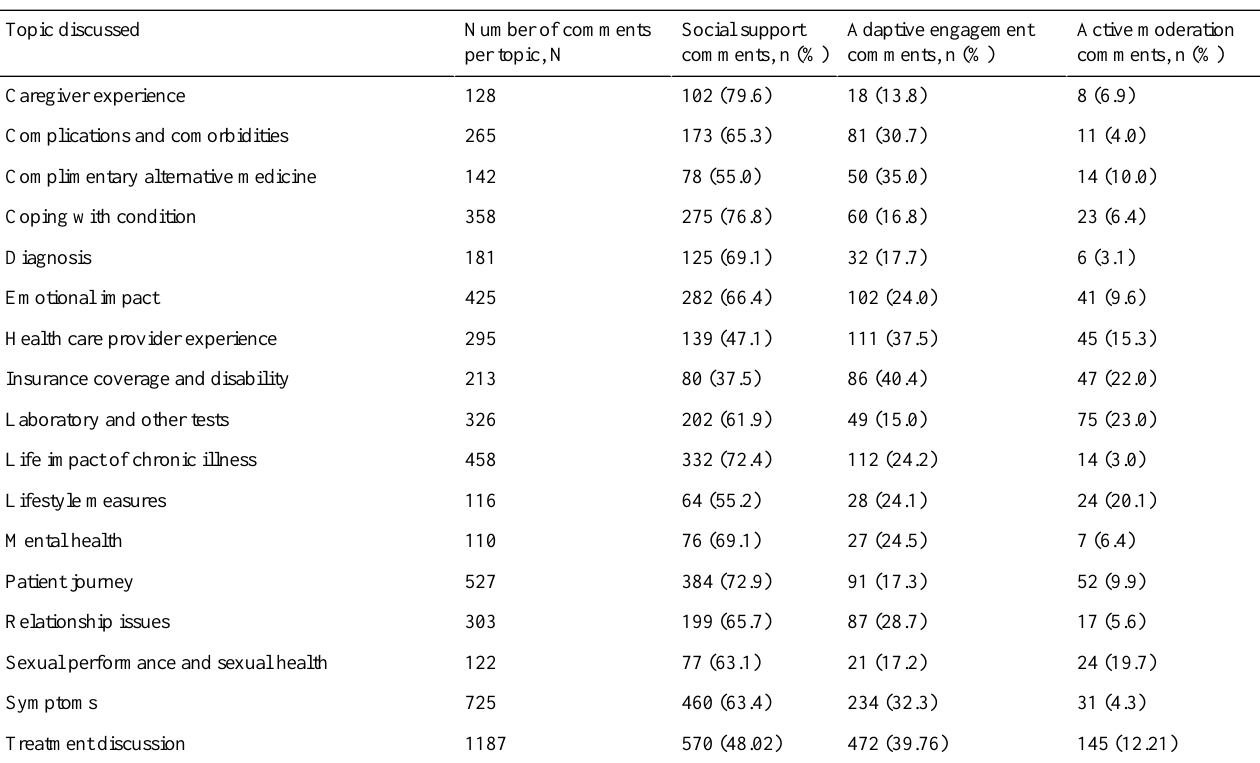
Table 3. Frequency distribution of model elements by topic